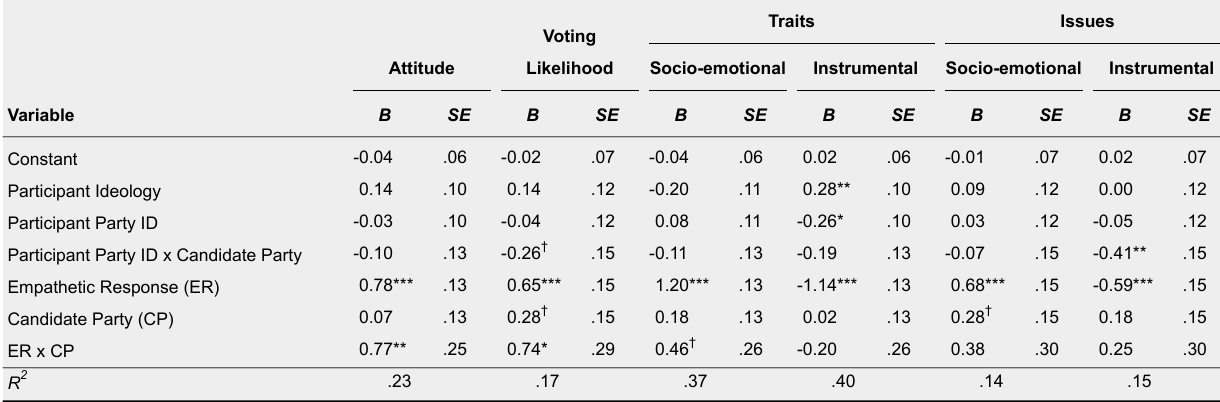
Candidate Ratings as a Function of Empathetic Response and Candidate Party, Study 2